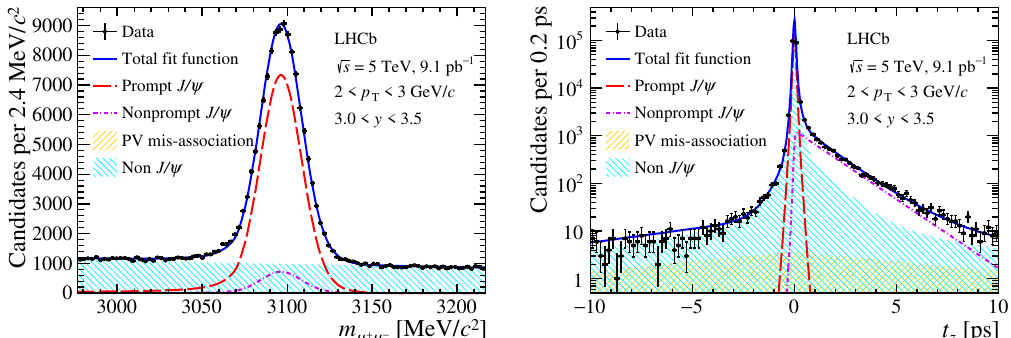
Figure 1 . Distributions of (left) invariant mass and (right) pseudoproper time of the J/ψ candidate for an example interval corresponding to 2 < p T < 3 GeV/ c and 3 . 0 < y < 3 . 5 . Projections of the two-dimensional fit are also